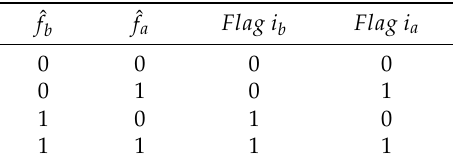
Table 1. Faults detection decision